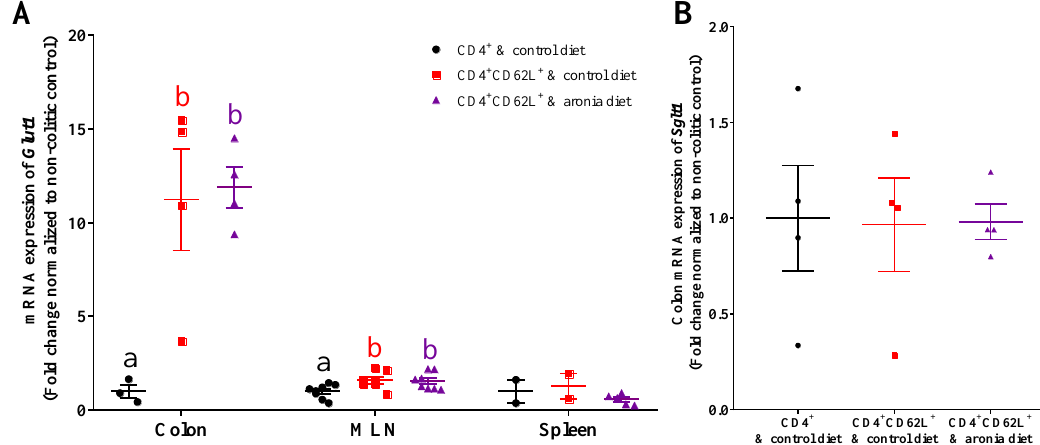
Figure 6. Aronia berry does not affect the expression of glucose transporters in colitic mice. Splenic CD4 + CD62L + cells from C57BL/6J mice were transferred to Rag1 -/- mice. Mice consumed the AIN-93M diet (colitic control) or aronia-supplemented diet for five weeks. A third group of Rag1 -/- mice received splenic CD4 + cells, consumed AIN-93M diet, and served as the non-colitic control. ( A ) Glut1 (glucose transporter 1) in the colon ( n = 4 – 5/group), mesenteric lymph node (MLN) ( n = 9 – 10/group), and spleen ( n = 3 – 5/group). ( B ) Sglt1 (sodium glucose cotransporter 1) expression in colon ( n = 4 – 5/group). The mRNA expressions in Rag1 -/- mice were normalized to Eef2 (eukaryotic translation elongation factor 2) and Rplp0 (ribosomal protein large P0) genes. Bars bearing different letters indicate significant differences between treatments ( p < 0.05).